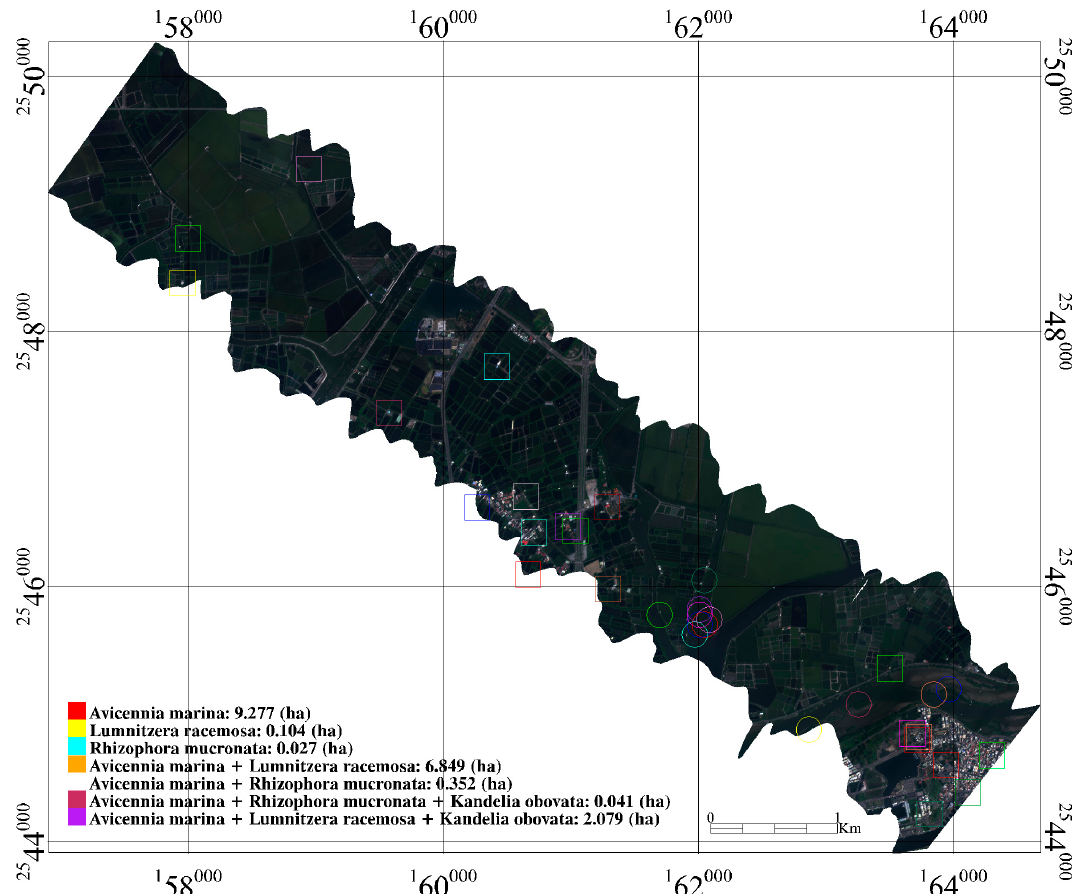
Figure 8. The locations of endmembers determined by calculating the Pixel Purity Index (PPI) from the MNF-inversed image. The 21 colorful square boxes were obtained from the case of an entire strip and the 12 colorful circles were obtained from the case of the training area only.